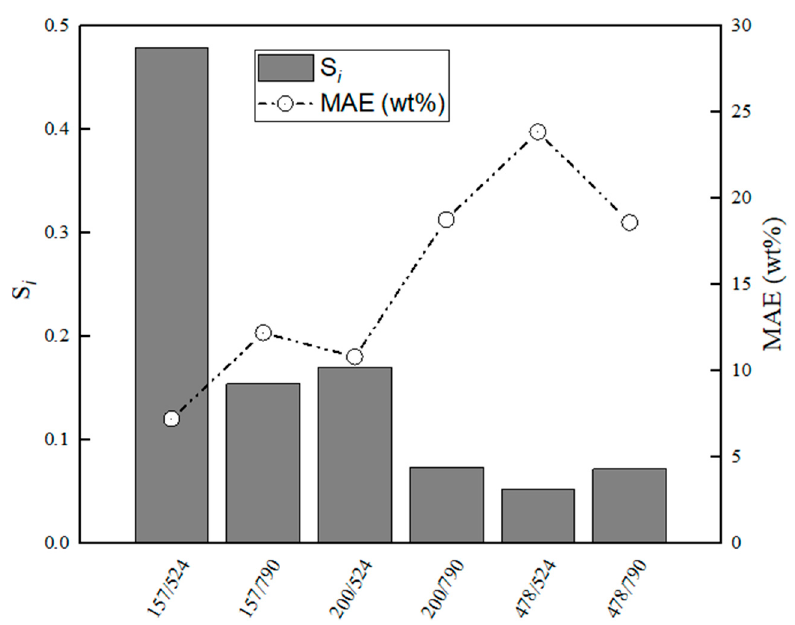
Figure 9. Evaluation of relative stabilities (Si) of the calibration variable candidates and mean absolute error values obtained for training and validation sets for CaS–CA.